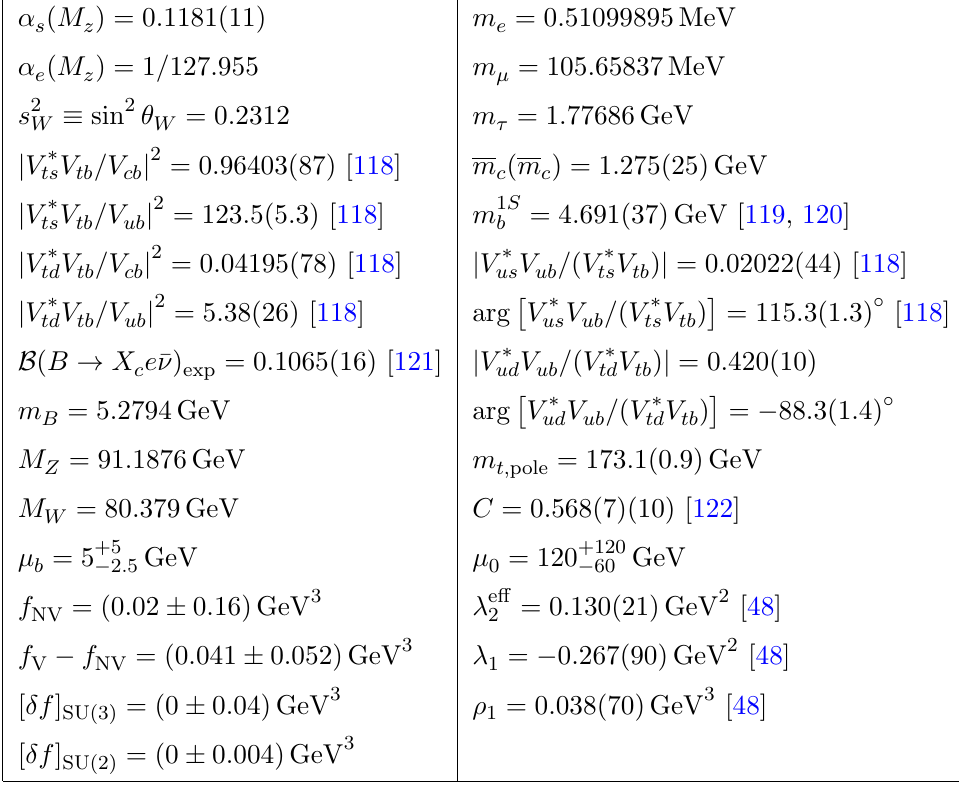
Table 5 . Numerical inputs used in the phenomenological analysis. Unless speci(cid:12)ed otherwise, they are taken from PDG [92]. In order to avoid somewhat uncontrolled non-perturbative e(cid:11)ects, we use the pole mass of the top quark obtained from cross section measurements. The CKM matrix elements have been obtained by propagating the uncertainties on the four CKM Wolfenstein parameters ( (cid:21) , A , (cid:22) (cid:26) and (cid:22) (cid:17) ) taken from the global (cid:12)t as of Summer 2018 presented by the CKM(cid:12)tter Group [118]. All HQET matrix elements are calculated between physical B mesons. Only